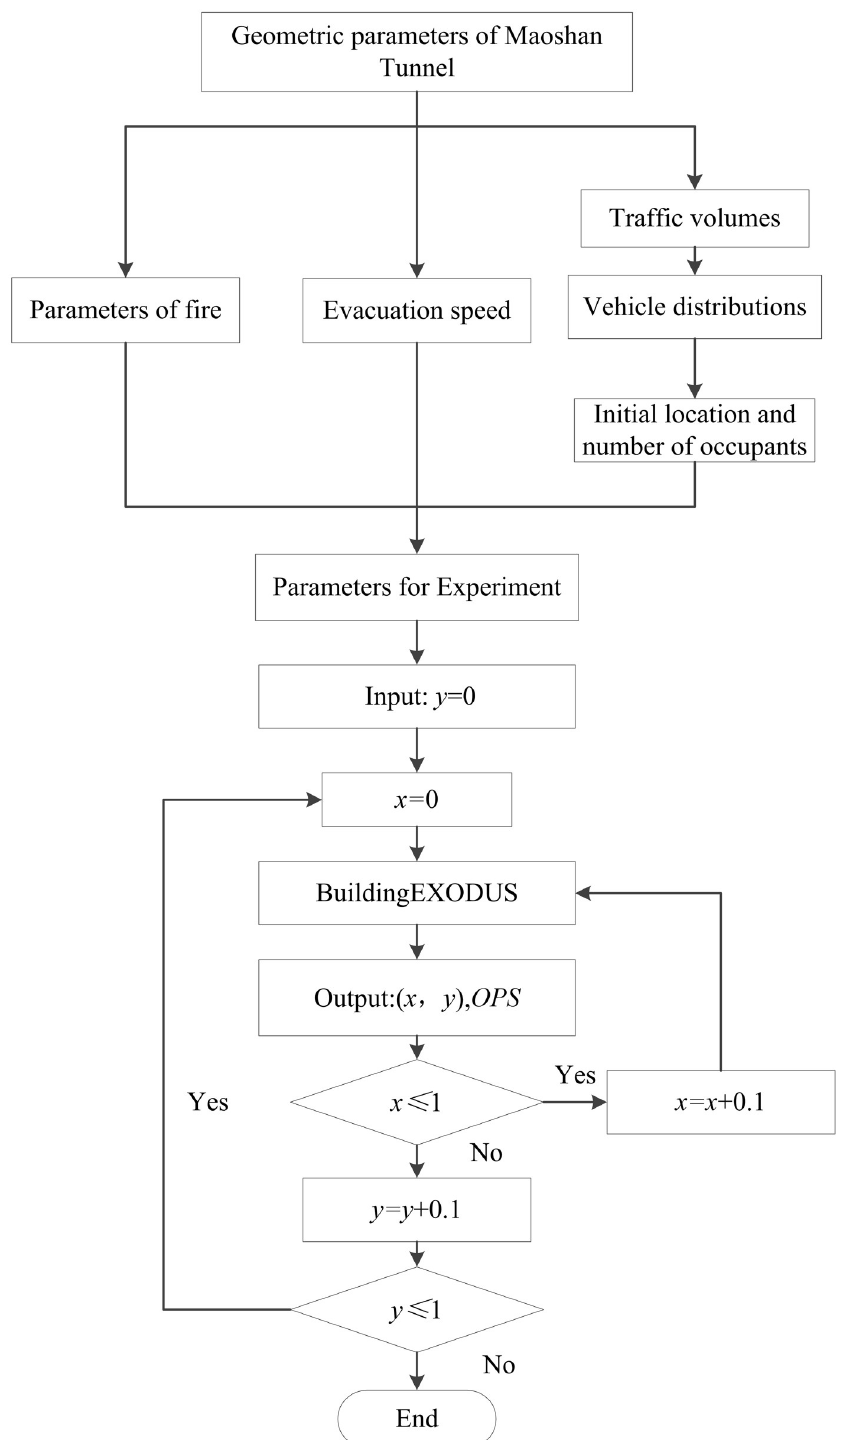
Fig 4. Process of solving x , y and the corresponding OPS .